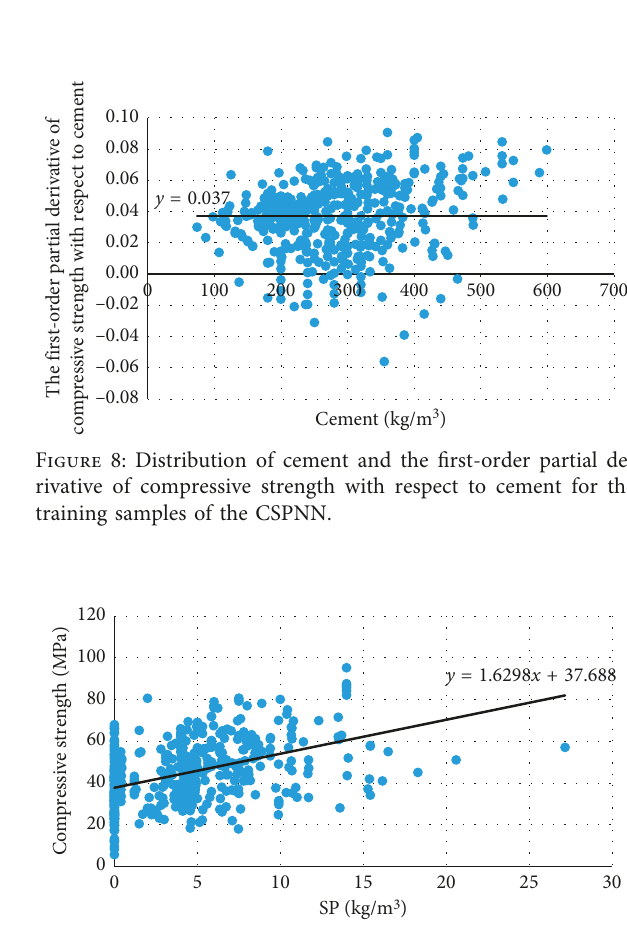
Figure 4: Performance of the 20 testing compressive strength samples.